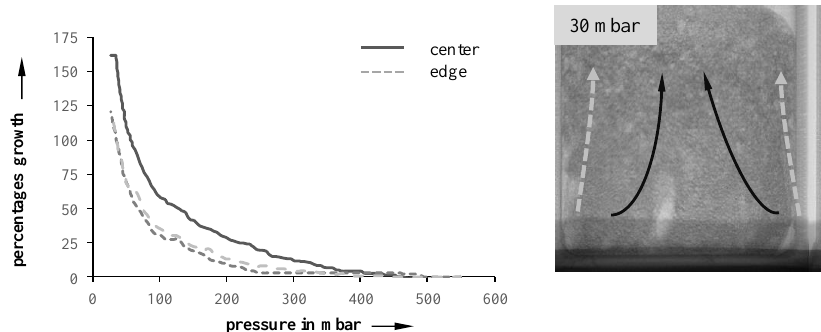
Figure 5. Edge effects on foaming at 23 °C (10 mbar/s).